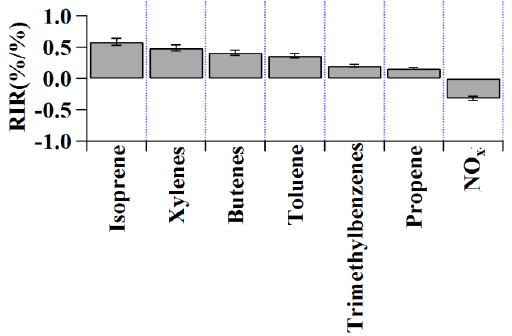
Figure 9. Top 6 VOC species/groups with the highest relative incremental reactivity (RIR) at the backgarden site during the sampling period.